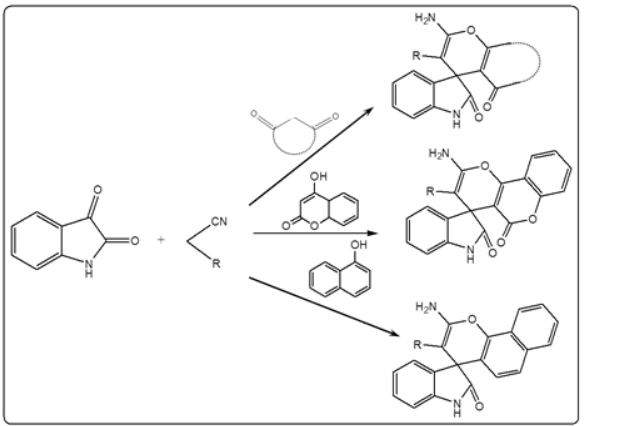
Figure 21: Selective oxidation of sulfides to sulfoxides bu using DES. p p See Dai et al. [87] for detailed reaction components and conditions.